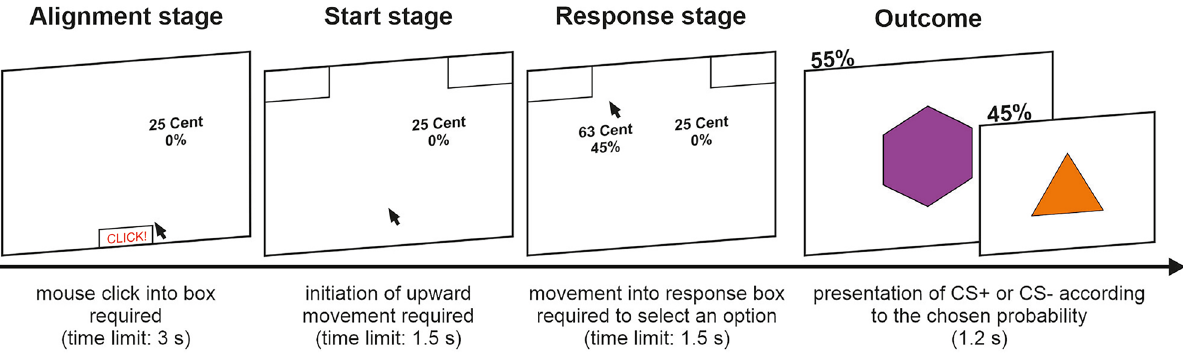
Figure 1. Schematic representation of the trial sequence. First, the CS−/low reward option was presented, and participants had to click into a small box at the bottom of the screen (time limit: 3 s). Second, an upward movement was required until the mouse cursor crossed an invisible line 50 pixels above the starting position (time limit: 1.5 s). Third, the CS+/high reward option appeared, and participants could choose one of the options by moving the mouse cursor to the response box of their preferred option (time limit: 1.5 s). Finally, the CS+ (orange triangle) was presented with the chosen probability (duration: 1.2 s). In trials without CS+ presentation, the CS− (purple hexagon) was